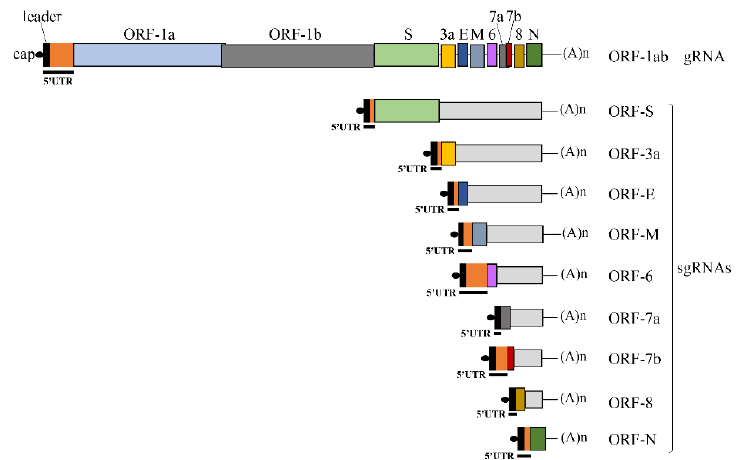
Figure 1. Scheme of the SARS-CoV-2 gRNA and sgRNAs. The cap and poly(A) tail structures are indicated. The 5 ′ UTR of each viral mRNA is underlined and is composed of the common leader sequence (black square) and the variable region (orange square). The other different colors correspond to the different ORFs as indicated on the